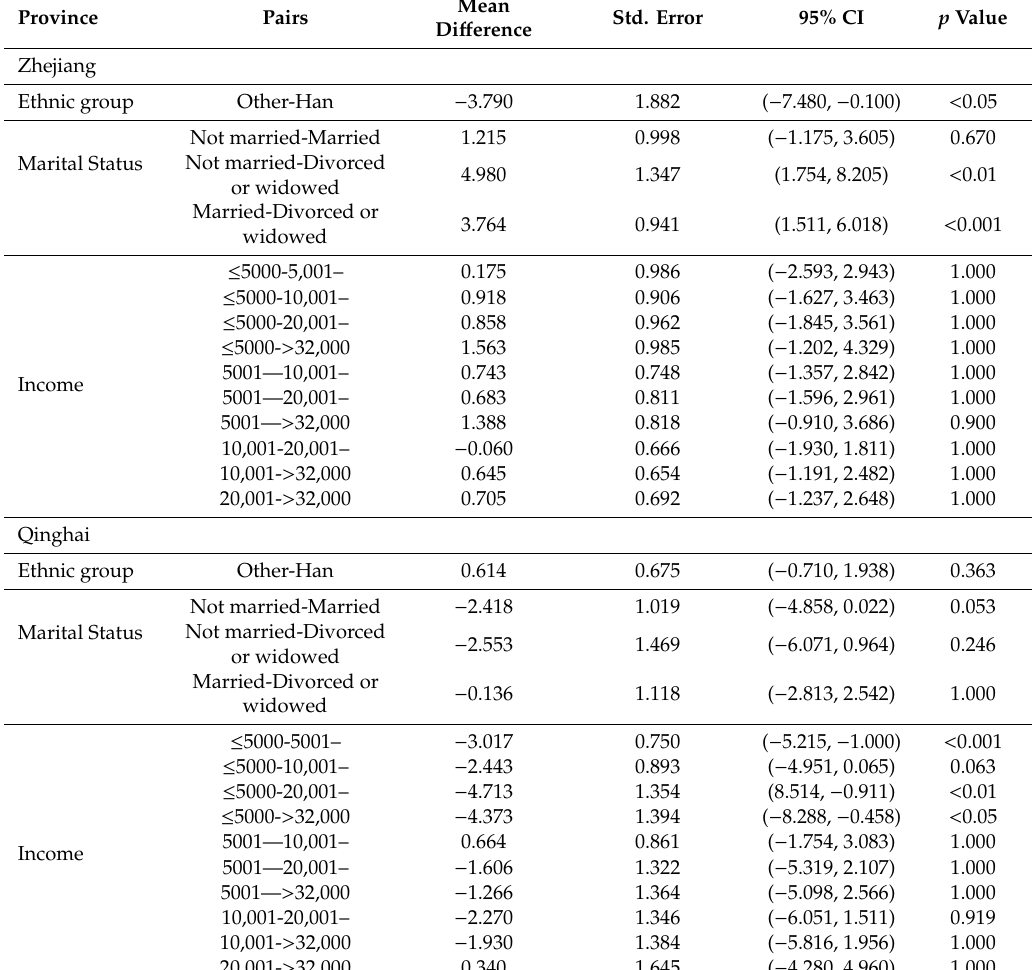
Table 6. Pairwise comparisons of interaction factors influencing the EQ VAS score (classified by province).